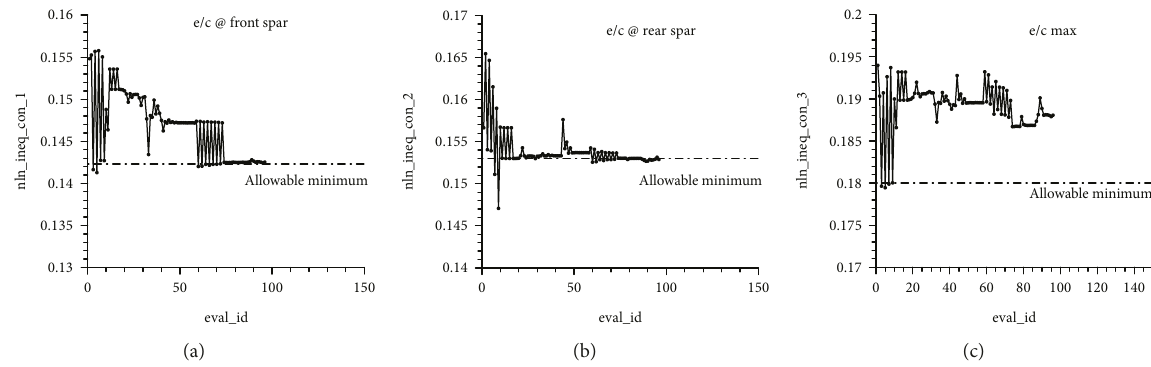
Figure 5: Evolution of the di ff erent thicknesses during the optimization process for root airfoil.